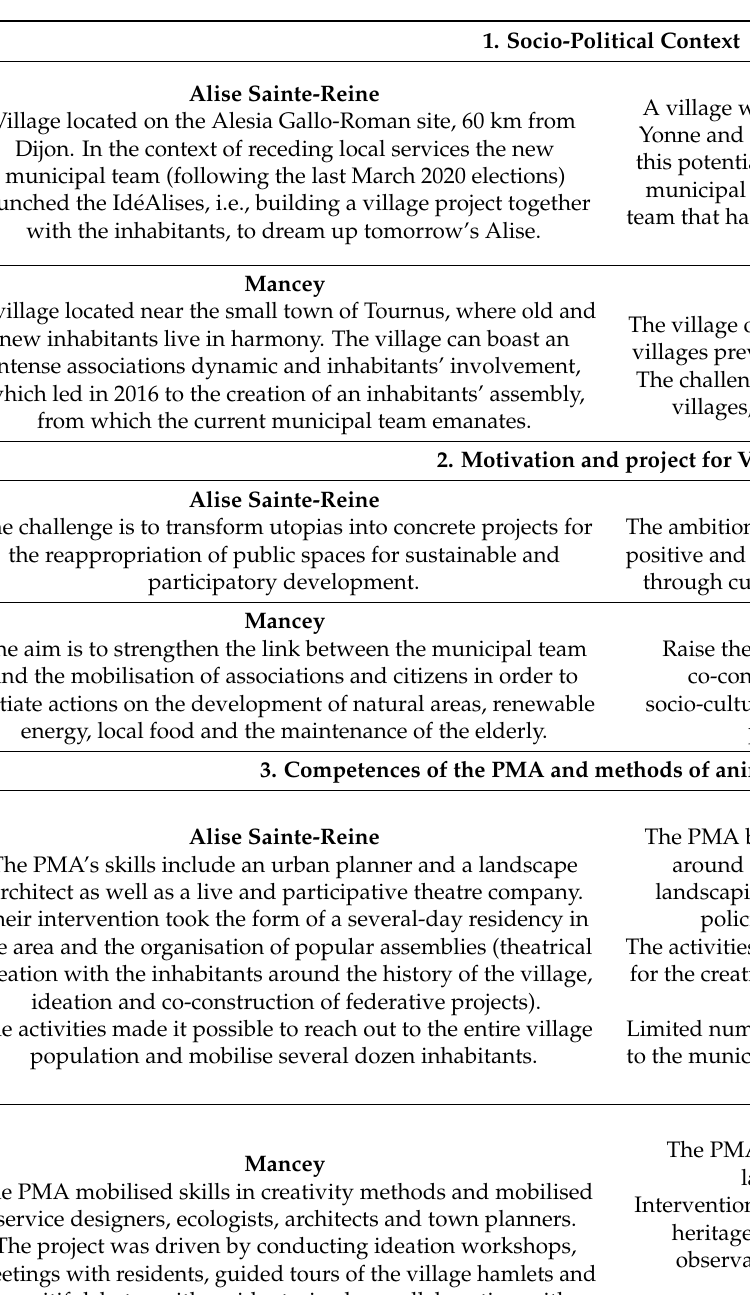
Table 2. Context and configuration of VDF implementation in the 4 villages